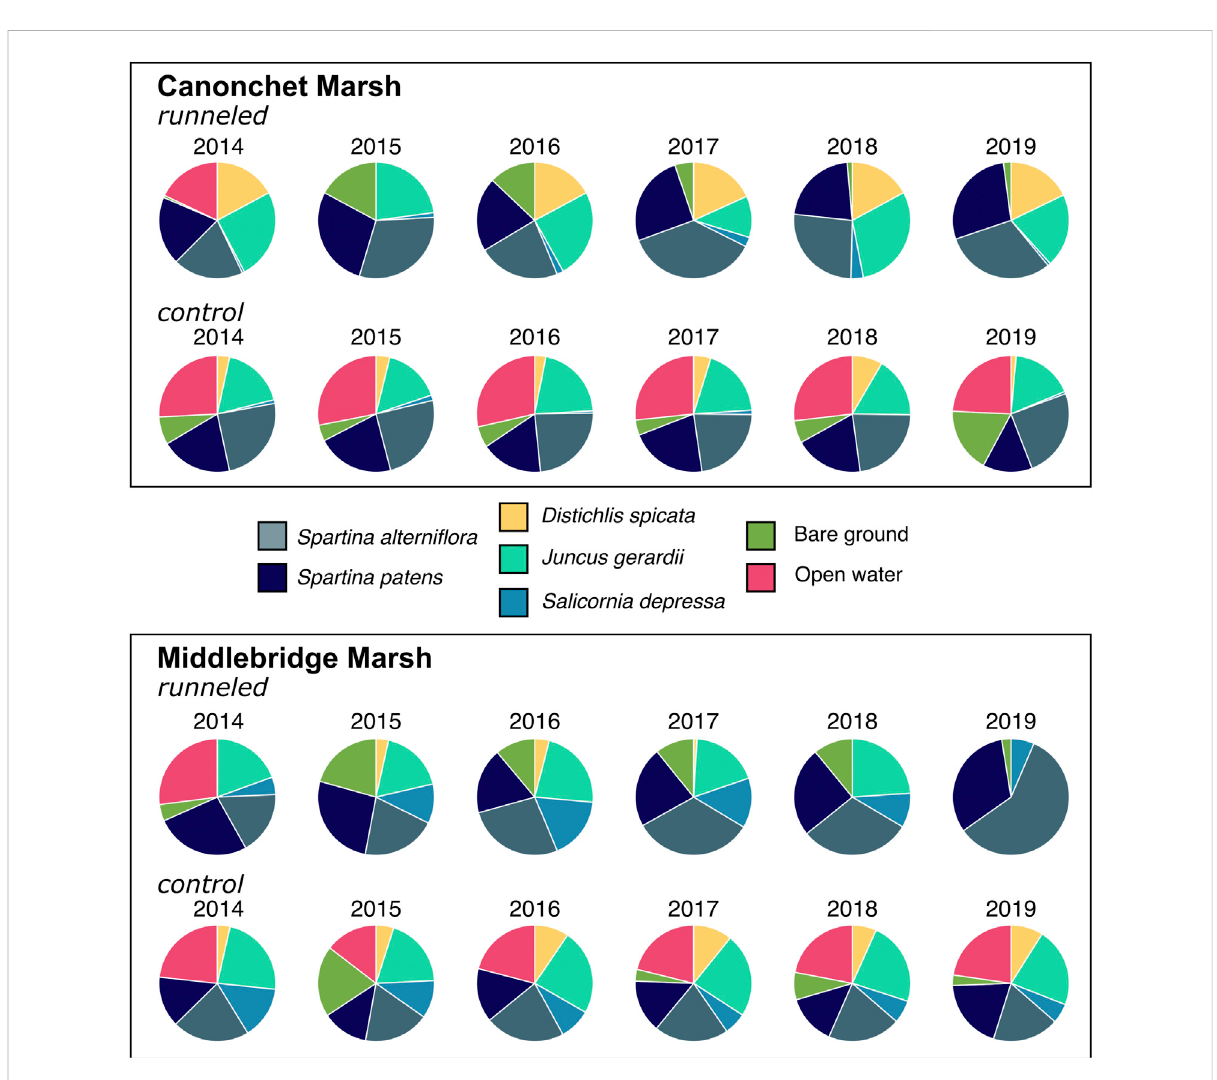
FIGURE 4 Relative abundance of S. alterni fl ora , S. patens, D. spicata, J. gerardii, S. depressa, and area of open water and bare ground along runneled and control transects at Canonchet and Middlebridge in 2014 (pre-runneling) through 2019. Runneling occurred in 2015 and